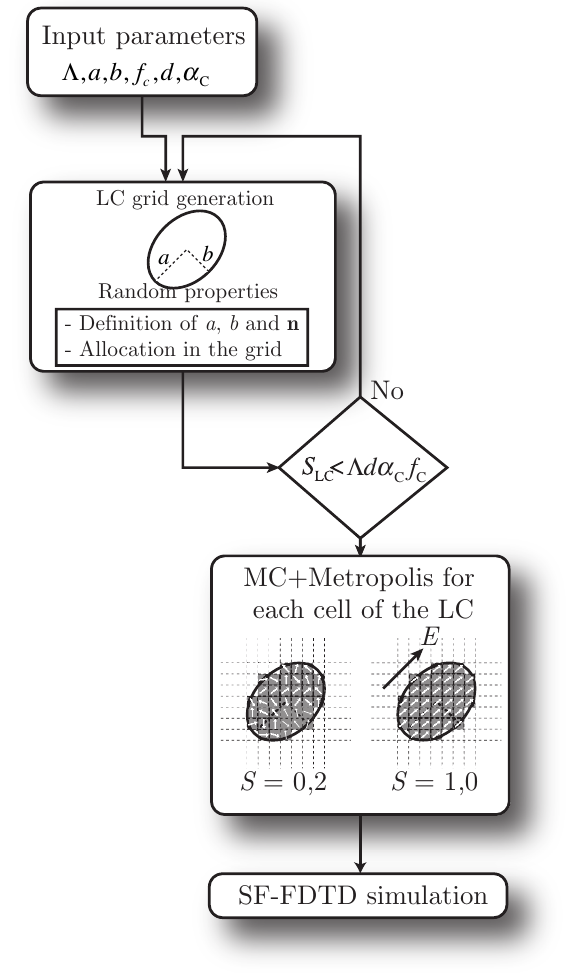
Figure 3. Diagram scheme of the method for simulating H-PDLC. SF,